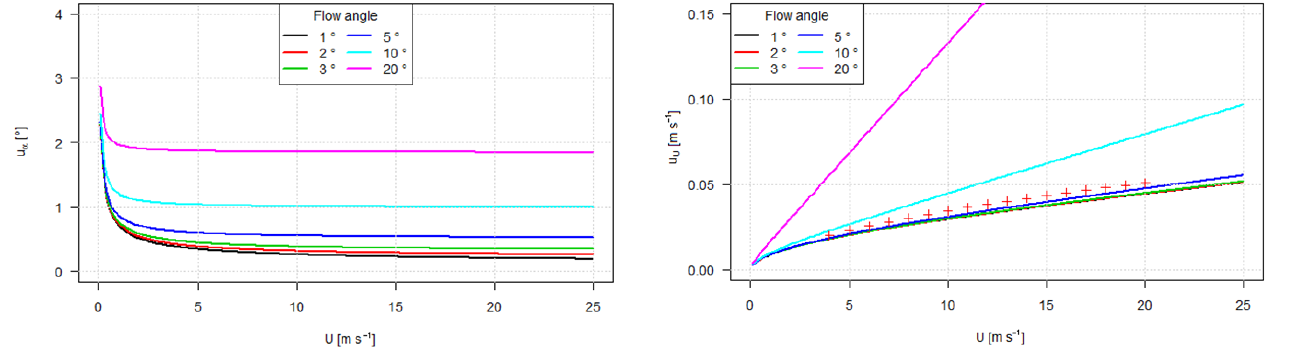
Figure 14. Uncertainty in the inflow angle α . Figure 15. Uncertainty in wind speed ( u U ) as a function of wind speed ( U ), for six possible values of inflow angle α . Red crosses show the values of uncertainty as a function of wind speed for a common value of inflow angle of 6 ◦